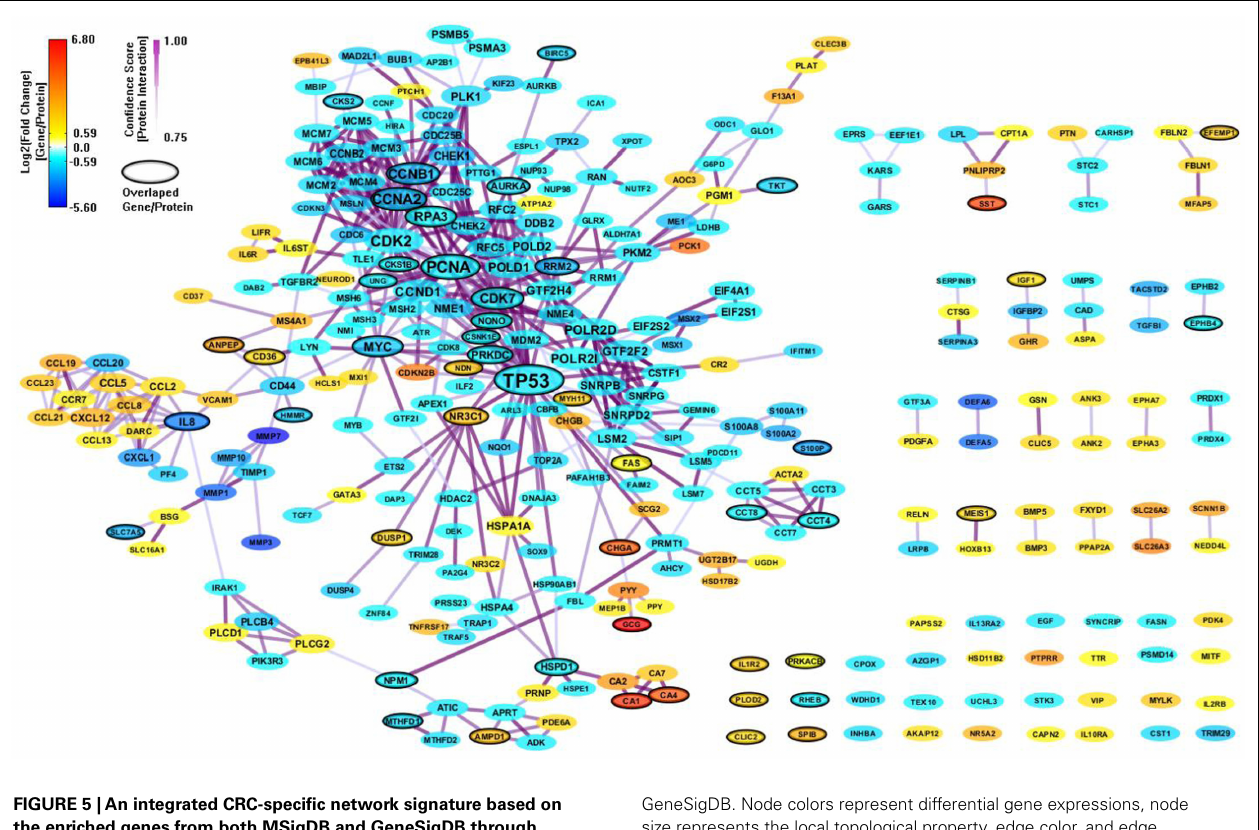
FIGURE 5 |An integrated CRC-specific network signature based on the enriched genes from both MSigDB and GeneSigDB through analyzing GSE8671 by gene set enrichment analysis (GSEA). The genes/proteins in the network were obtained from GSEA analysis using “colon” related gene signatures searched from both MSigDB and